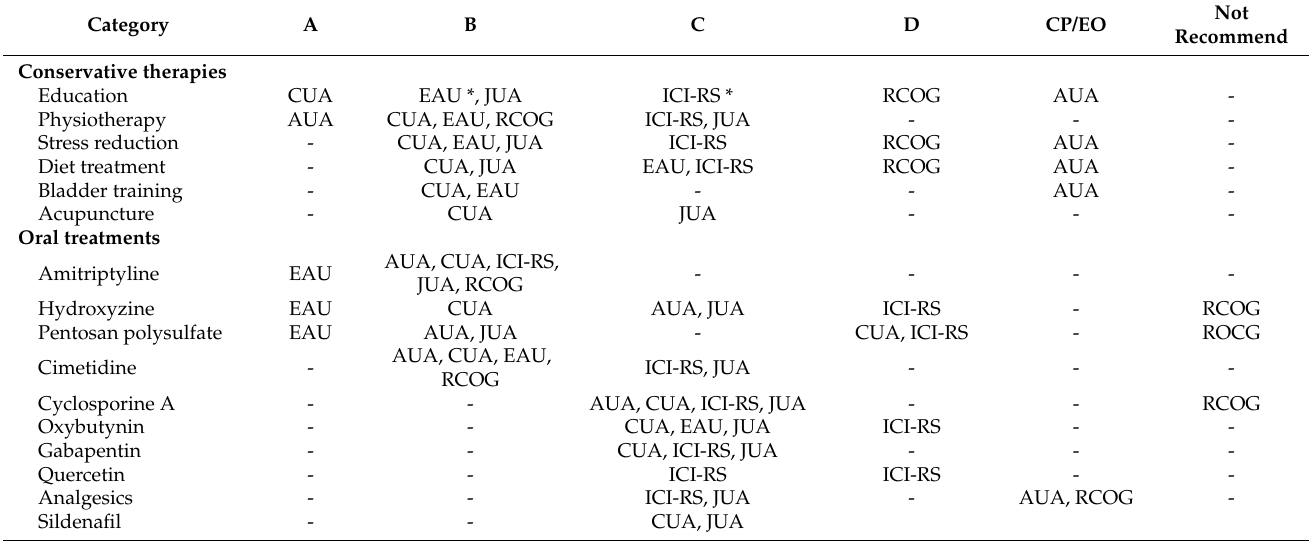
Table 1. The present treatments for IC/BPS based on grade of